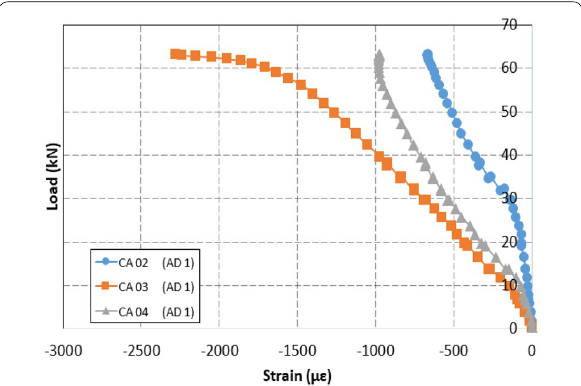
Fig. 10 AD concrete load–strain curve.